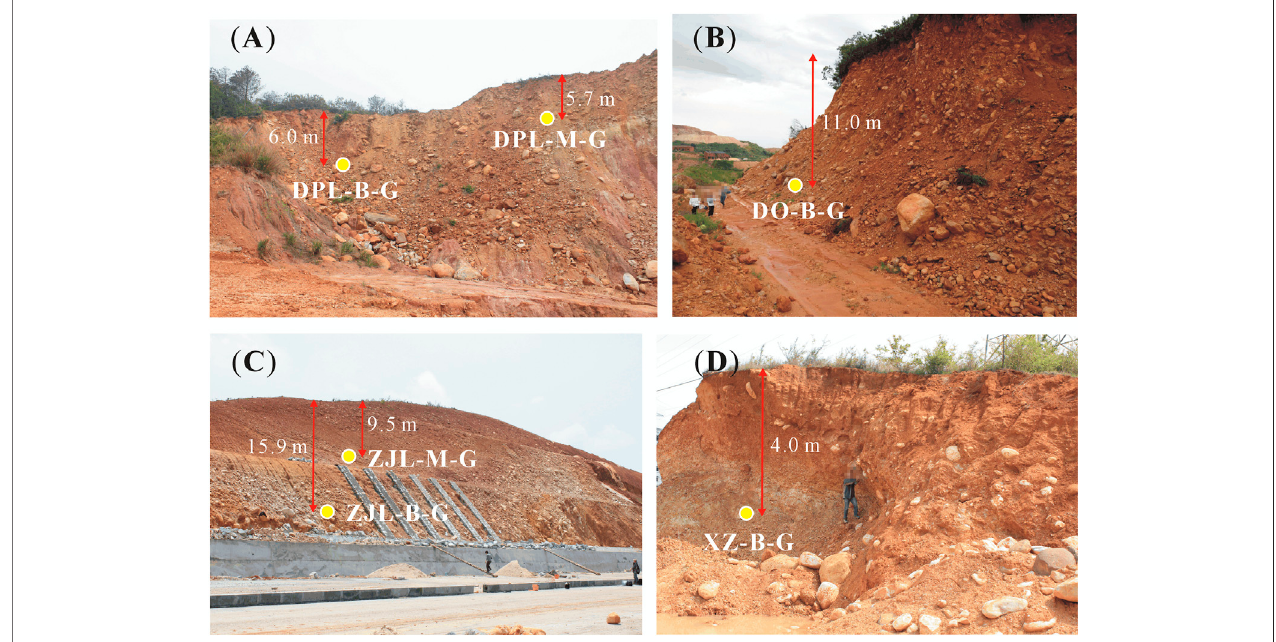
FIGURE6| PhotographsshowthesedimentsonthefantotheeastofLuMountainandthesamplinglocations. (A) ColluviumatDapailing. (B) Debris fl owdeposits at Daao. (C) Alluvium at Zhangjialong. (D) Debris fl ow deposits at Xingzi.